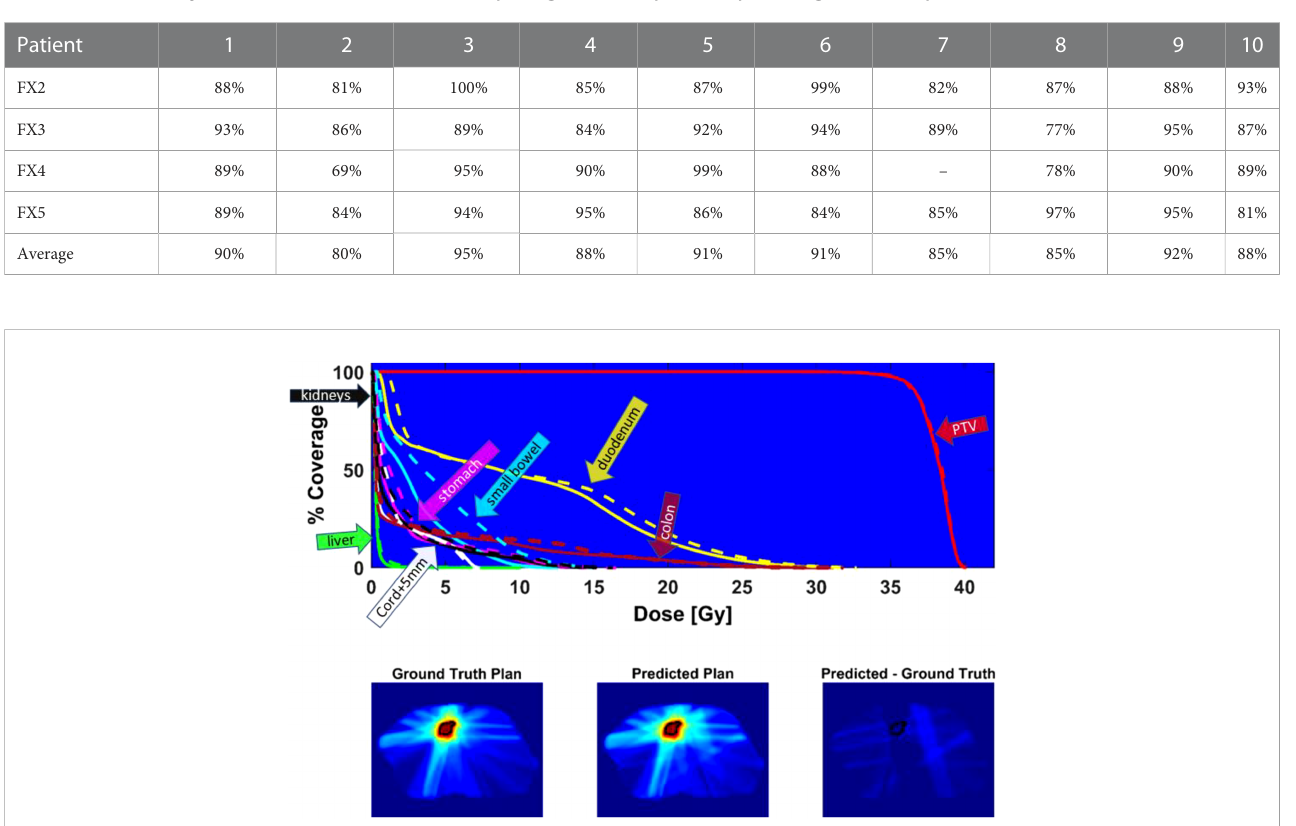
TABLE 2 Gamma Analysis (3%,3mm,5% threshold): Percent passing rate of the predicted plan and ground truth